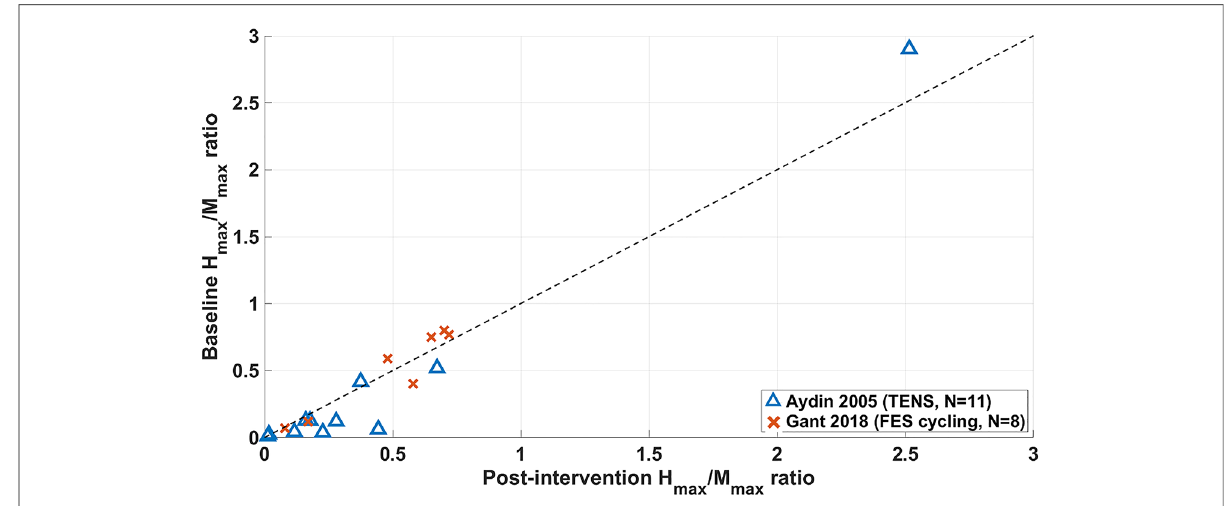
FIGURE 7 Changes from baseline to end-of-intervention in Hmax/Mmax ratio of long-term non-RCT studies. FES=functional electrical stimulation, TENS= transcutaneous electrical nerve